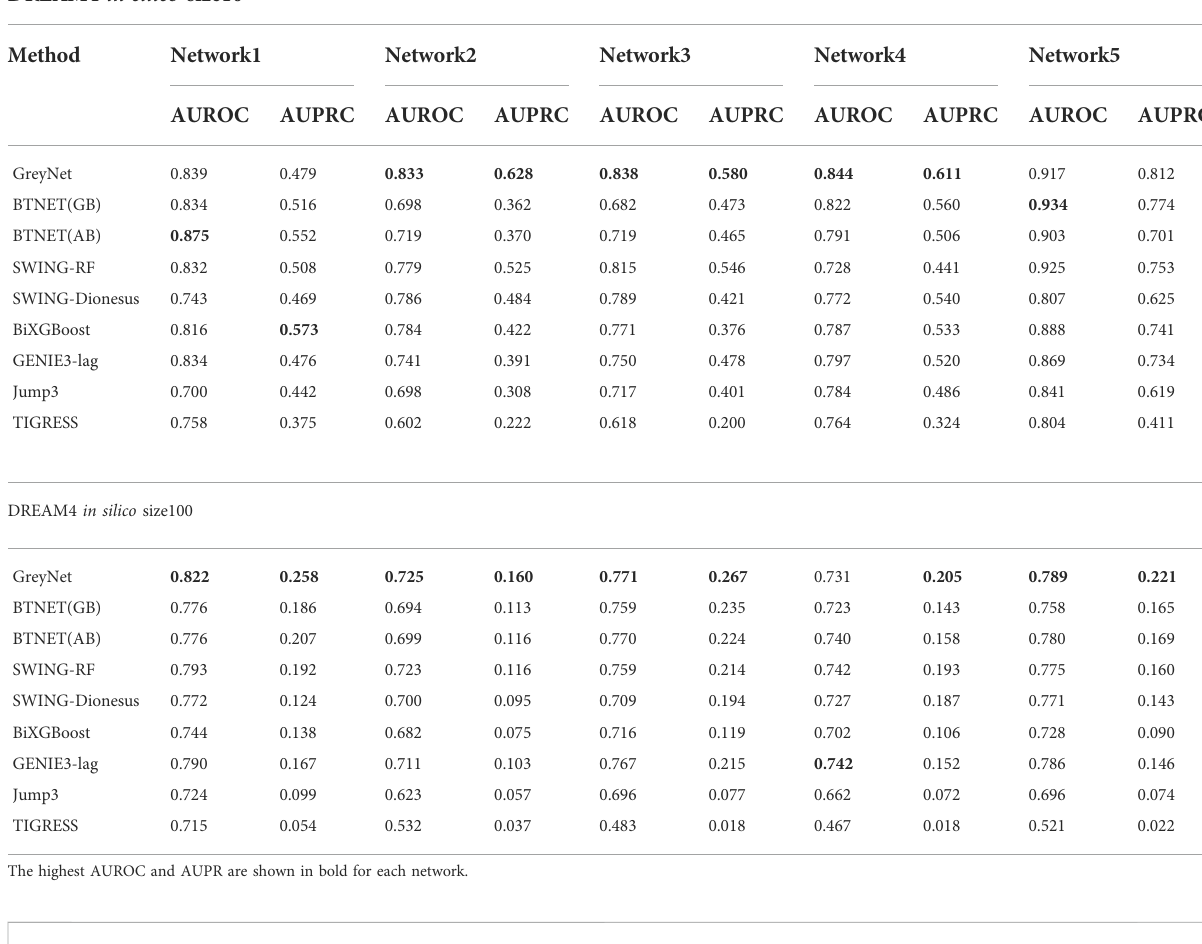
TABLE 3 The comparative results of models on DREAM4 data.